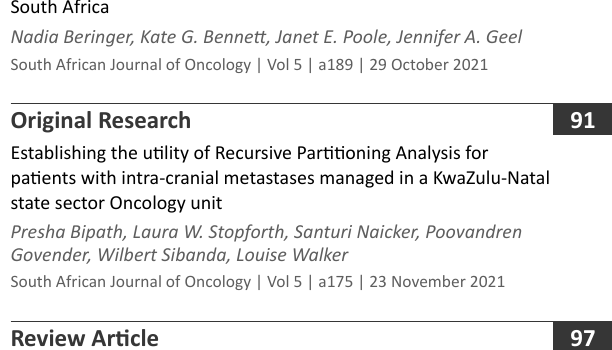
Delays in the referral and primary management of cutaneous